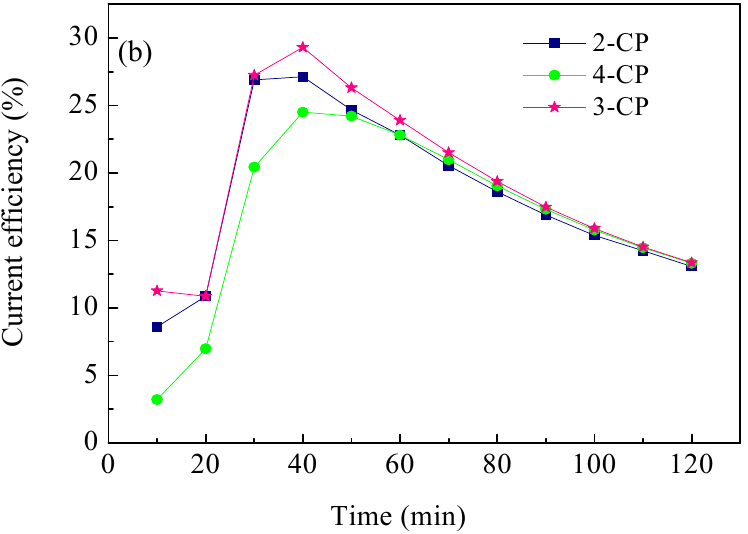
Figure 6. The removal rate ( a ) and current efficiency ( b ) as a function of time during the electrocatalytic hydrodechlorination (ECH) of monochlorophenols.